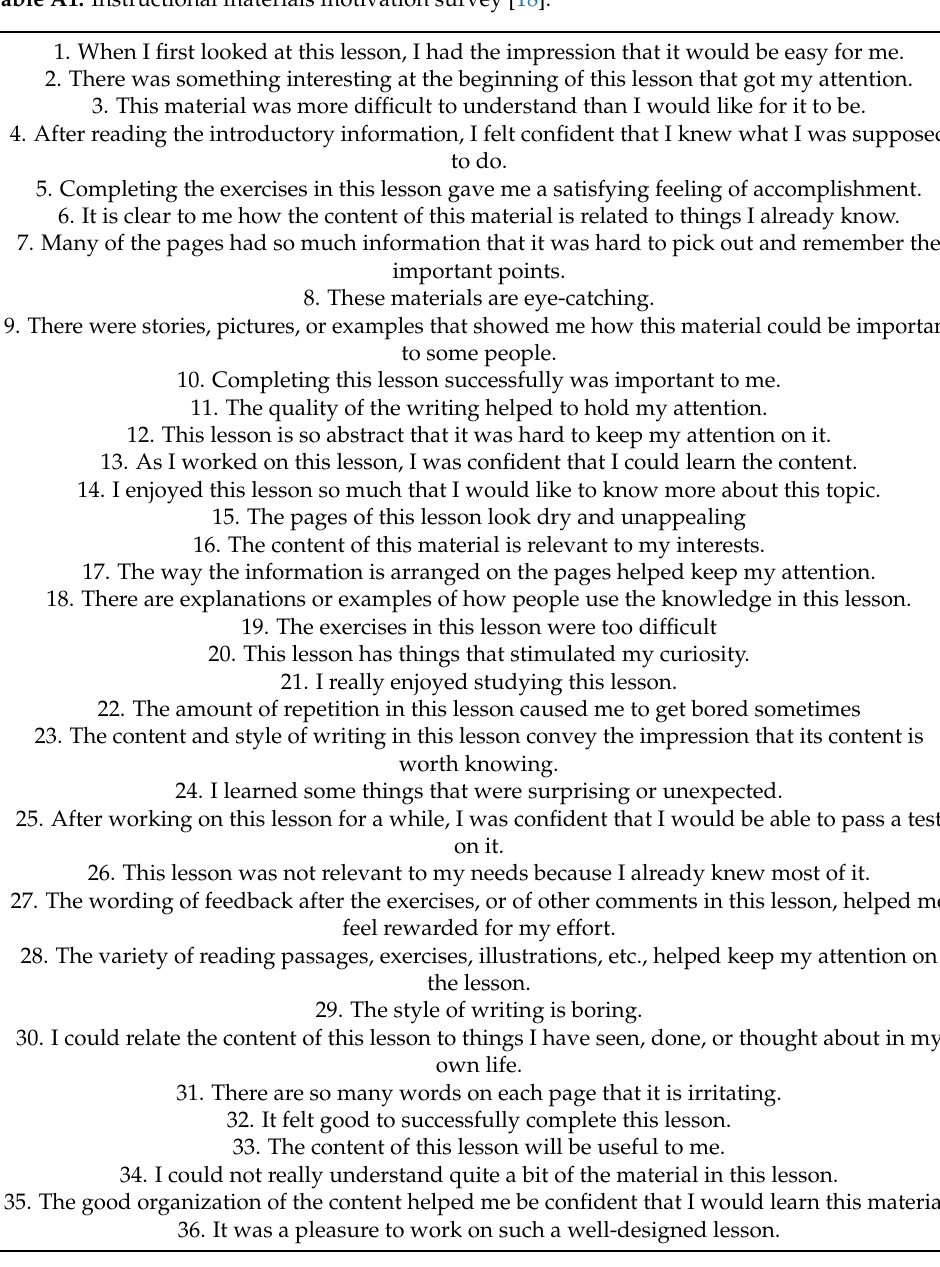
Table A1. Instructional materials motivation survey